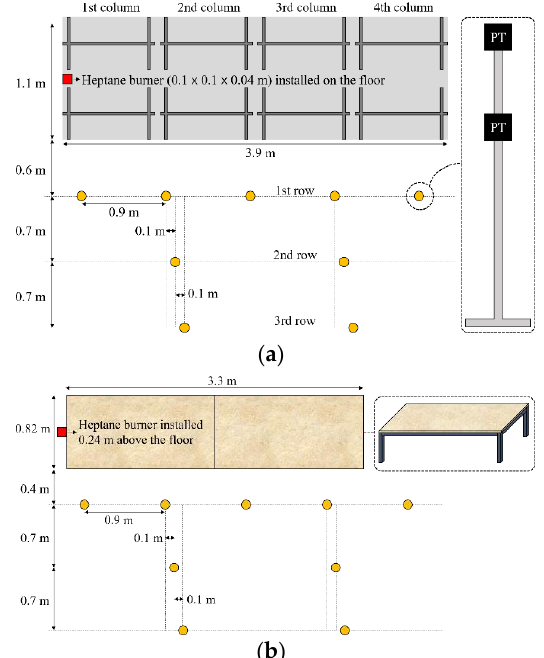
Figure 4. Layout of plate-thermometer stands for measuring the incident radiant heat flux of major combustibles: ( a ) Experiment with clothing hanging on hangers; ( b ) experiment on combustibles placed on the stalls.